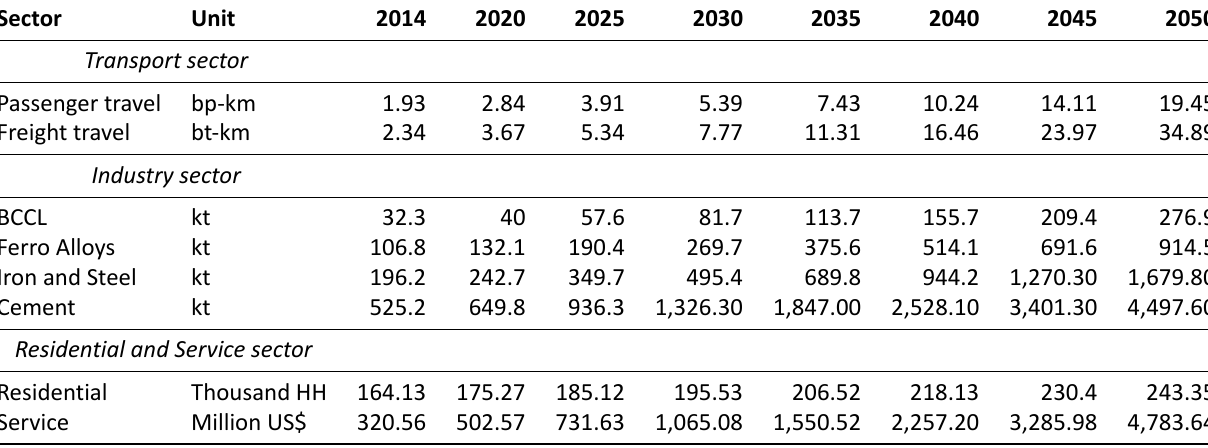
Table A12. Projected demand.